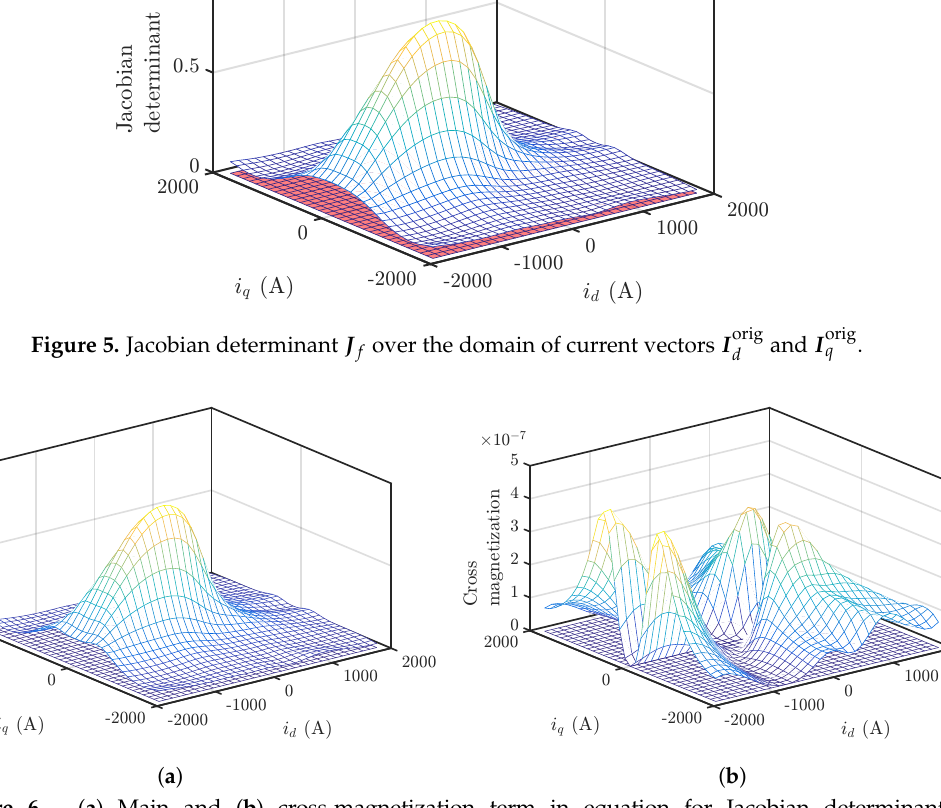
Figure 6. ( a ) Main and ( b ) cross-magnetization term in equation for Jacobian determinant. Note the different order of